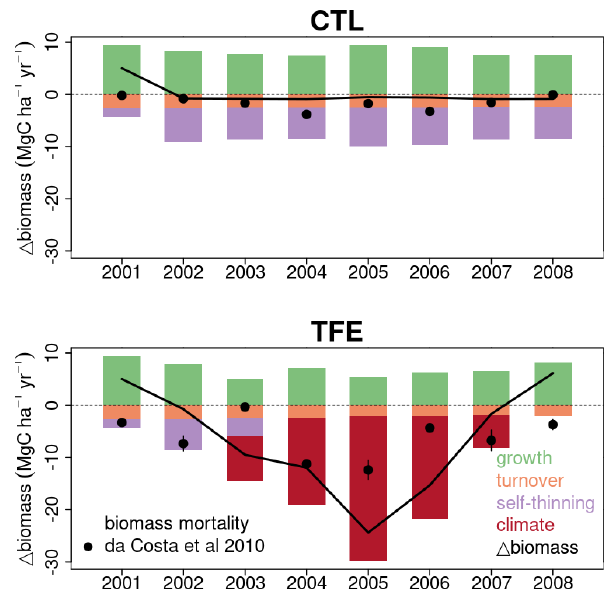
Figure 10. Simulated components of biomass change and observed net biomass change during 2001–2008. The observed net biomass change data in each year from da Costa et al. (2010) are plotted as black dot. The black line shows the net change of simulated biomass by